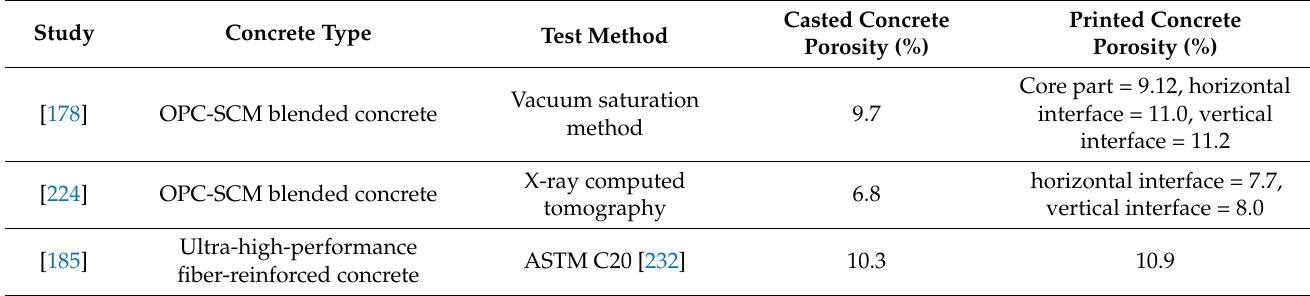
Table 5. Porosity of 3D-printed concrete versus casted